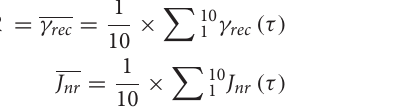
Frontiers in Materials |